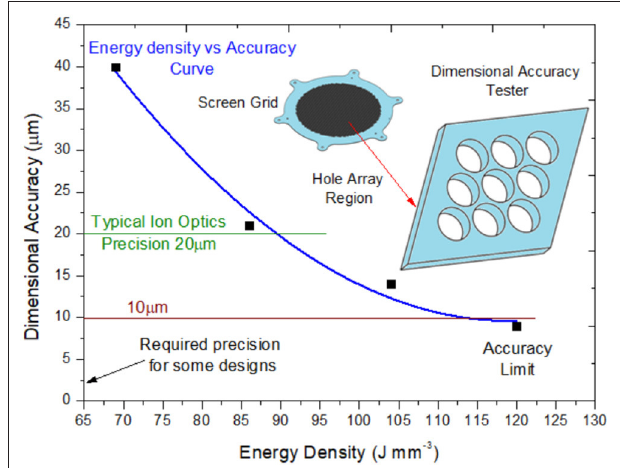
FIGURE 2 | Optimization process of the grid’s hole array dimensional accuracy.